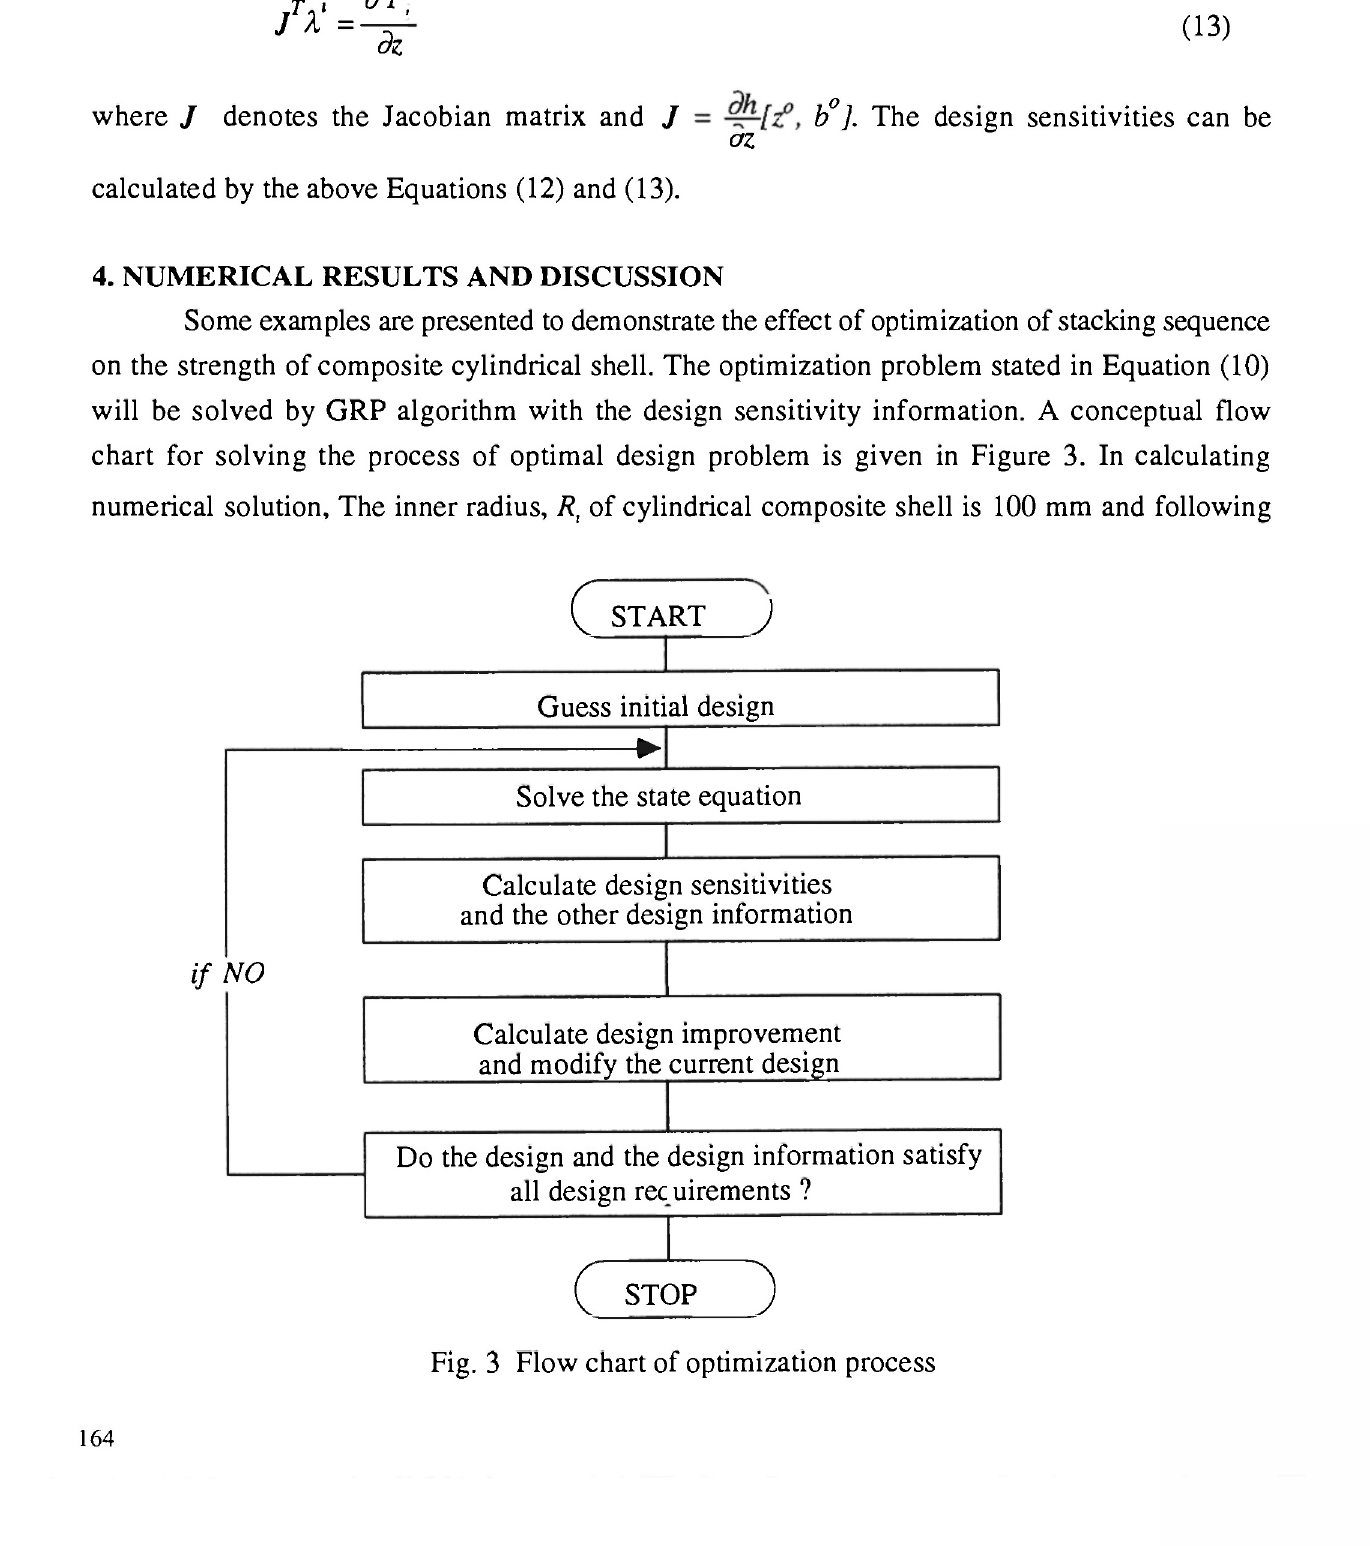
Fig. 3 Flow chart of optimization